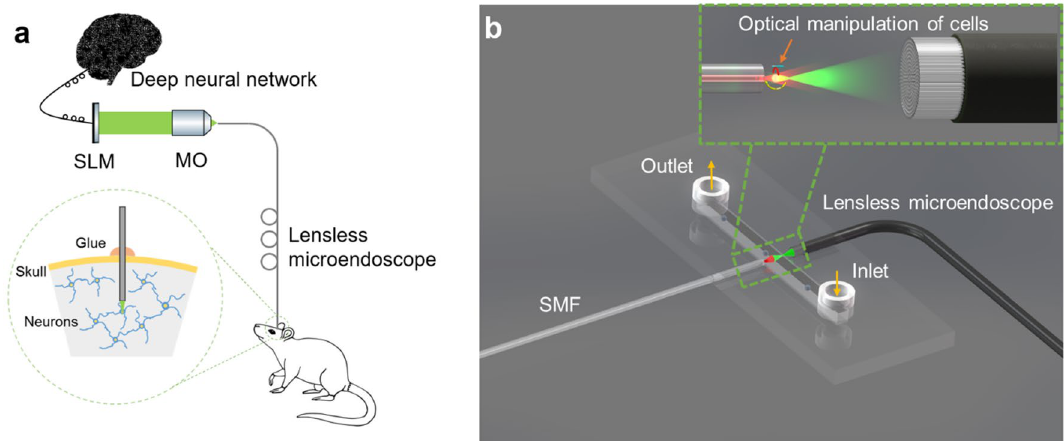
Figure 7. Application of the deep learning enhanced lensless microendoscope. ( a ) Sketch illustrates employing the lensless microendoscope for holographic photoactivation in mouse brain with minimum invasiveness. The tailored CGHs are generated on the fly by CoreNet. ( b ) Schematic demonstrates the MCF-based lab-on-a- chip optical manipulation system. CoreNet boosted the generation process of the tailored CGHs for the MCF, providing more degrees of freedom for MCF-based optical